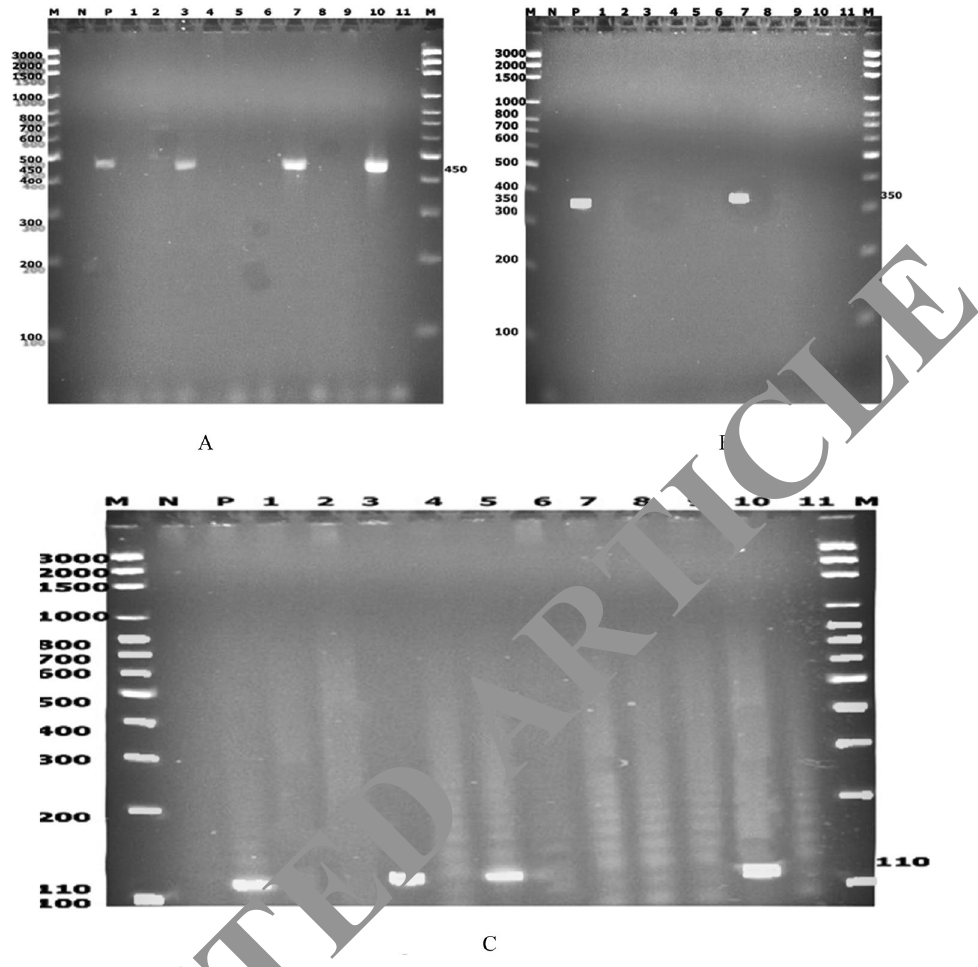
Figure 1. ( A – C ) Amplification of virulence genes in E. coli isolates from diarrheic calves and the images are a product of time averaged data. M marker, N negative control, P positive control; Numbers = 1–11 representative sample numbers; ( A ) eaeA gene with 450 bp; ( B ) stx2 gene with 350 bp; ( C ) stx1 gene with 110 bp.